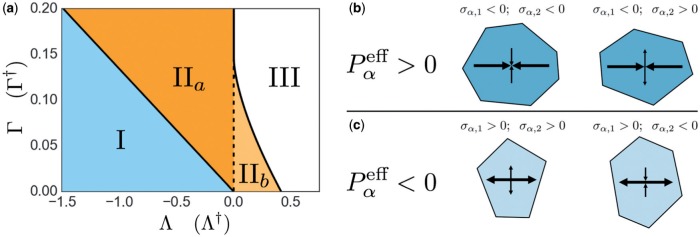
(a) \documentclass[12pt]{minimal}
\usepackage{amsmath}
\usepackage{wasysym} 
\usepackage{amsfonts} 
\usepackage{amssymb} 
\usepackage{amsbsy}
\usepackage{upgreek}
\usepackage{mathrsfs}
\setlength{\oddsidemargin}{-69pt}
\begin{document}
}{}$(\Lambda, \Gamma)$\end{document}-parameter space, showing boundaries for a uniform hexagonal array (following Farhadifar et al., 2007). Region I represents a ‘soft’ network with no shear resistance, bounded by (3.38); \documentclass[12pt]{minimal}
\usepackage{amsmath}
\usepackage{wasysym} 
\usepackage{amsfonts} 
\usepackage{amssymb} 
\usepackage{amsbsy}
\usepackage{upgreek}
\usepackage{mathrsfs}
\setlength{\oddsidemargin}{-69pt}
\begin{document}
}{}$P^{\text{eff}}=0$\end{document} has a single positive root in region II\documentclass[12pt]{minimal}
\usepackage{amsmath}
\usepackage{wasysym} 
\usepackage{amsfonts} 
\usepackage{amssymb} 
\usepackage{amsbsy}
\usepackage{upgreek}
\usepackage{mathrsfs}
\setlength{\oddsidemargin}{-69pt}
\begin{document}
}{}$_a$\end{document} and two positive roots in region \documentclass[12pt]{minimal}
\usepackage{amsmath}
\usepackage{wasysym} 
\usepackage{amsfonts} 
\usepackage{amssymb} 
\usepackage{amsbsy}
\usepackage{upgreek}
\usepackage{mathrsfs}
\setlength{\oddsidemargin}{-69pt}
\begin{document}
}{}$\text{II}_{b}$\end{document}. The network collapses in Region III, which is bounded by \documentclass[12pt]{minimal}
\usepackage{amsmath}
\usepackage{wasysym} 
\usepackage{amsfonts} 
\usepackage{amssymb} 
\usepackage{amsbsy}
\usepackage{upgreek}
\usepackage{mathrsfs}
\setlength{\oddsidemargin}{-69pt}
\begin{document}
}{}$\Lambda=0$\end{document} and (3.39). The transformation (3.40) allows \documentclass[12pt]{minimal}
\usepackage{amsmath}
\usepackage{wasysym} 
\usepackage{amsfonts} 
\usepackage{amssymb} 
\usepackage{amsbsy}
\usepackage{upgreek}
\usepackage{mathrsfs}
\setlength{\oddsidemargin}{-69pt}
\begin{document}
}{}$(\Lambda,\Gamma)$\end{document} to be replaced by \documentclass[12pt]{minimal}
\usepackage{amsmath}
\usepackage{wasysym} 
\usepackage{amsfonts} 
\usepackage{amssymb} 
\usepackage{amsbsy}
\usepackage{upgreek}
\usepackage{mathrsfs}
\setlength{\oddsidemargin}{-69pt}
\begin{document}
}{}$(\Lambda^\dagger,\Gamma^\dagger)$\end{document} in order to describe cases for which \documentclass[12pt]{minimal}
\usepackage{amsmath}
\usepackage{wasysym} 
\usepackage{amsfonts} 
\usepackage{amssymb} 
\usepackage{amsbsy}
\usepackage{upgreek}
\usepackage{mathrsfs}
\setlength{\oddsidemargin}{-69pt}
\begin{document}
}{}$P_{\mathrm{ext}}\neq 0$\end{document}. (b,c) Classification of cell stress configurations in a disordered monolayer, showing representative cell shapes. Larger (smaller) arrows indicate the orientation of the eigenvector associated with the eigenvalue of the stress tensor having larger (smaller) magnitude, where \documentclass[12pt]{minimal}
\usepackage{amsmath}
\usepackage{wasysym} 
\usepackage{amsfonts} 
\usepackage{amssymb} 
\usepackage{amsbsy}
\usepackage{upgreek}
\usepackage{mathrsfs}
\setlength{\oddsidemargin}{-69pt}
\begin{document}
}{}$\vert\sigma_{\alpha,1}\vert\geq \vert\sigma _{\alpha, 2}\vert \geq 0$\end{document}. Inward- (outward)-pointing arrows indicate the tension (compression) generated by the cell. (Colour in online.)